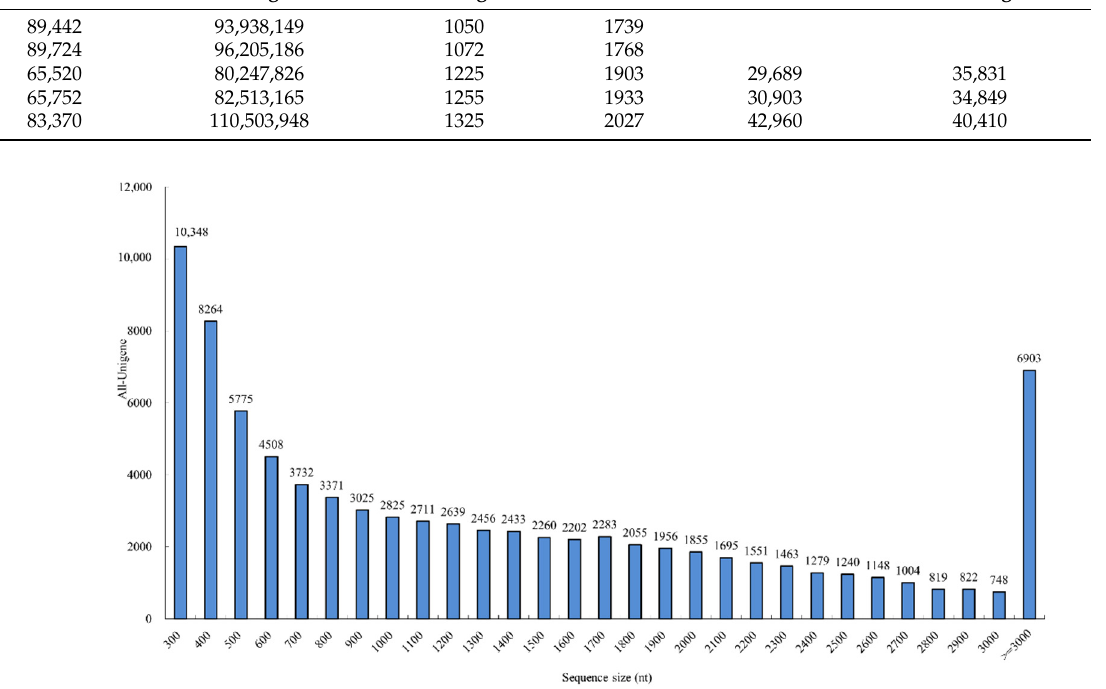
Figure 2. Sequence length distribution of the unigenes in P. chinensis .